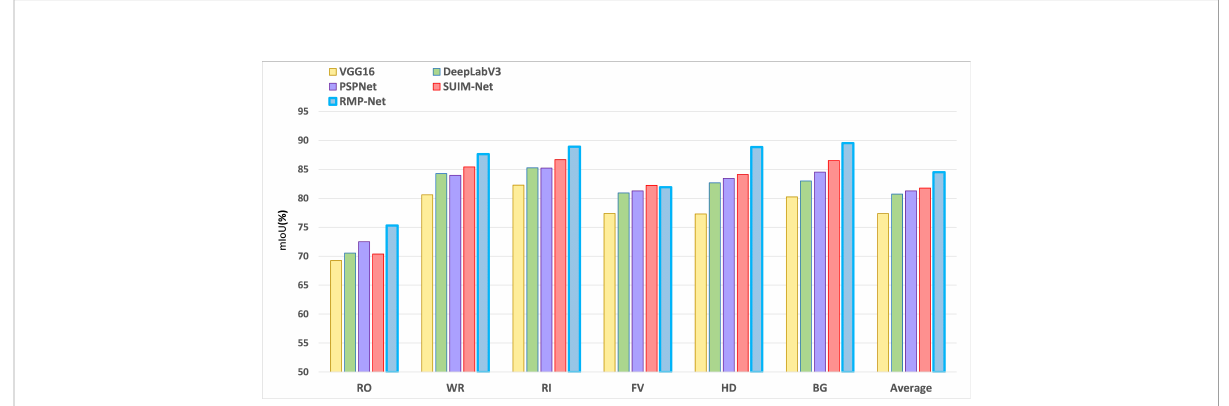
FIGURE 6 Testing different mainstream segmentation networks on the SUIM dataset, RepVGG, and subpixel convolution helps to improve the performance of the segmentation model, illustrating the effectiveness of RMP-Net in the task of ocean scene